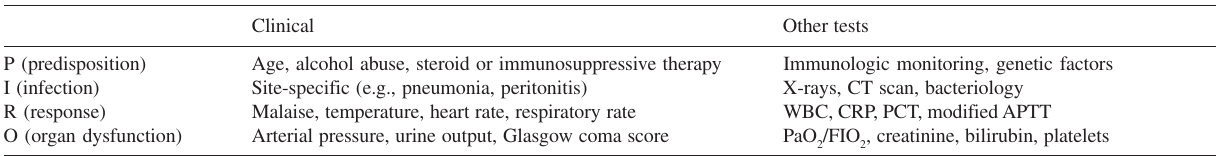
Table 2 - PIRO concept Clinical Other